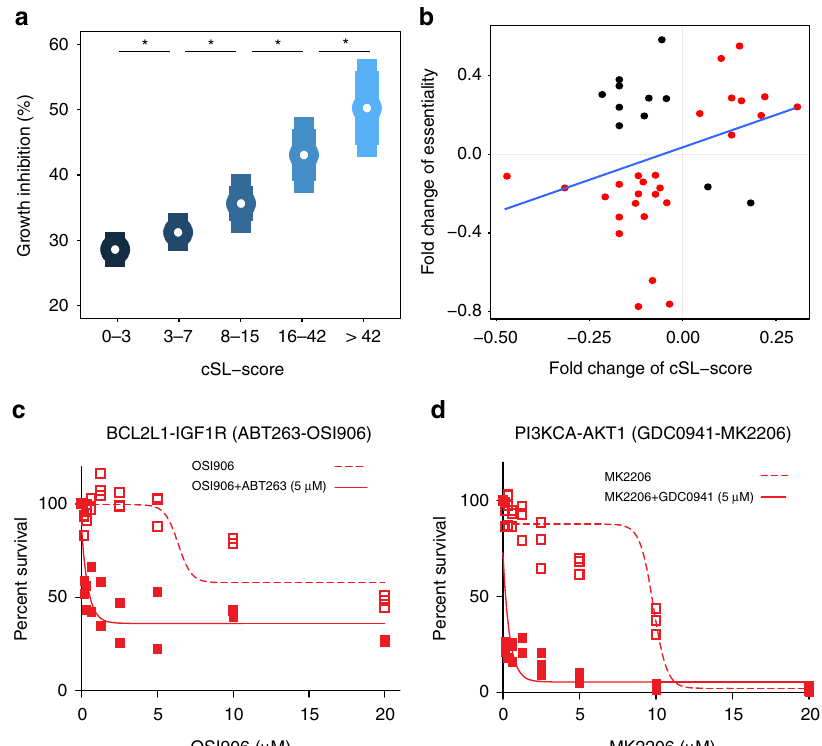
Fig. 3 New experiments to test ISLE-based predictions on growth inhibition and drug combinations. a , b cSL-based prediction of growth inhibition in a knockdown screen in oral cancer. a Growth rate prediction: The number of downregulated cSL partners of a gene ( X -axis; cSL-score) is associated with the percentage of growth inhibition observed after its knockdown ( Y -axis; quanti fi ed as percent-growth inhibition compared to control, mean and s.e.m). Each bin of cSL-score shows signi fi cant differences (FDR-corrected t -test P < 0.2*, see Supplementary Note 1). b cSL-based context-speci fi c prediction of growth inhibition in hypoxic vs normoxic conditions. The fold change of cSL-score (X-axis in logscale) in normoxia vs. hypoxia shows a positive correlation with the corresponding growth inhibition fold change ( Y -axis in logscale), correctly predicting the differentially observed growth inhibition in more than 71% of the 38 cases observed experimentally (marked as red dots in the 1st and 3rd quadrants). c , d The fi gures depict the representative dose response curves (see Supplementary Fig. 7B, C for other cell lines) of the predicted synergistic drug combinations of c ABT263 (BCL2L1 inhibitor) and the OSI906 (IGF1R inhibitor) and d GDC0941 (PIK3CA inhibitor) and the MK2206 (AKT1 inhibitor). The percentage of cell line survival ( Y -axis) was measured at varying doses of OSI906 (respectively MK2206), with and without ABT263 (respectively GDC0941) treatment at 5uM ( X -axis). The dashed lines denote the percentage of cell line survival at varying levels of OSI906 (MK2206) without ABT263 (GDC0941) treatments, and the solid lines denote the